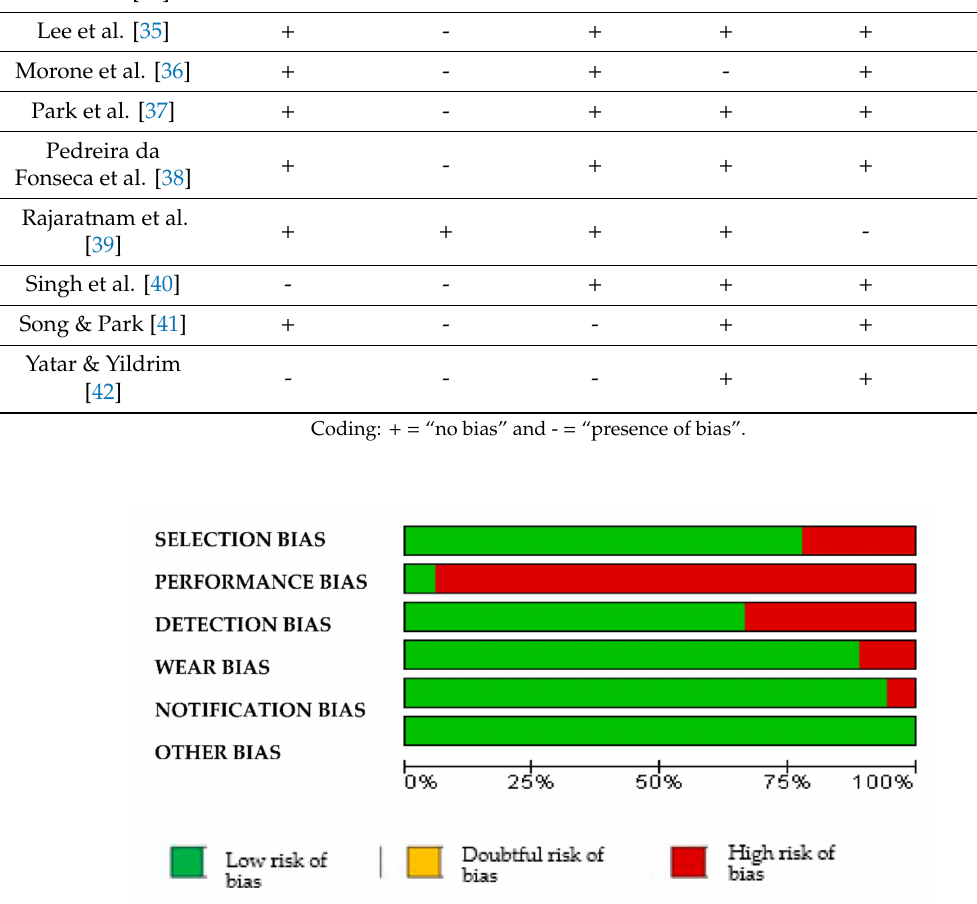
Figure 2. Risk of bias